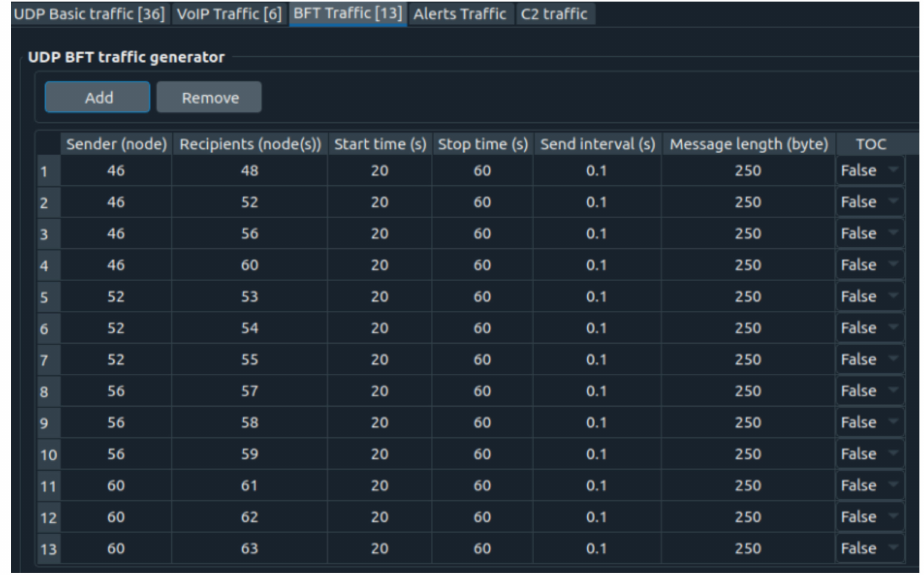
Figure 15. BFT traffic